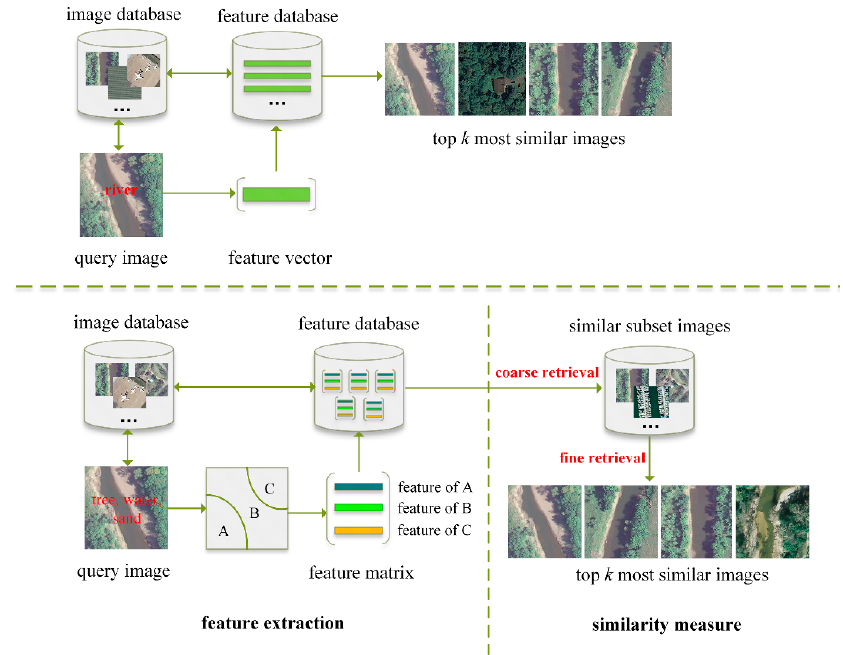
Figure 1. Comparison of single-label and multi-label RSIR.